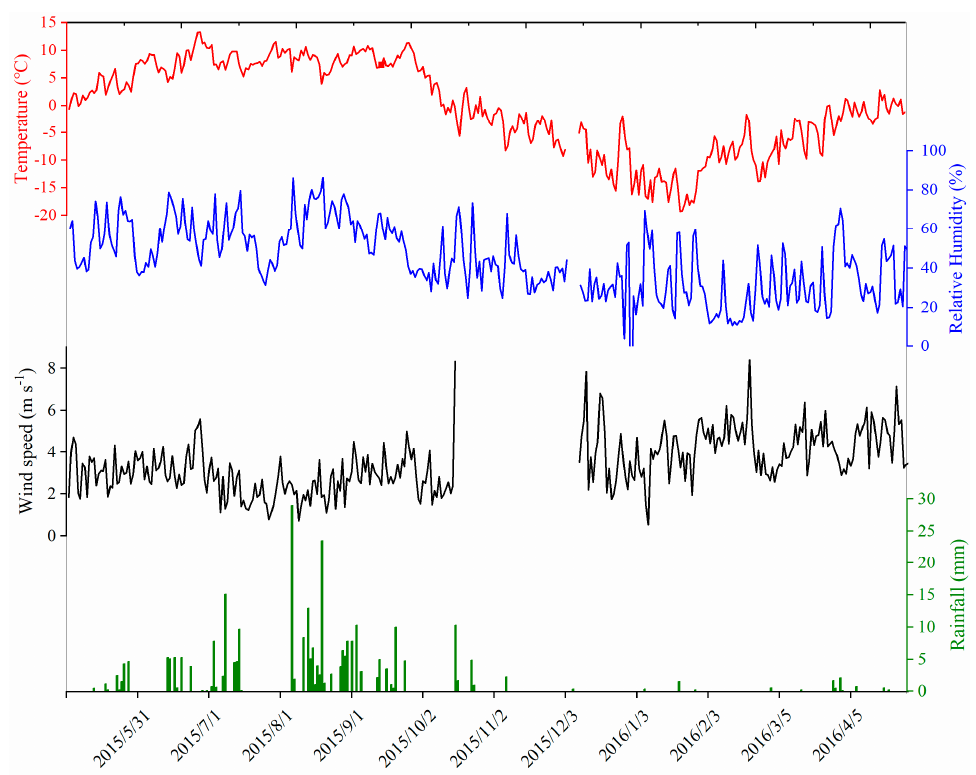
Figure 2. Elementary meteorological observations at the Nam Co Lake (NCL) Station from May